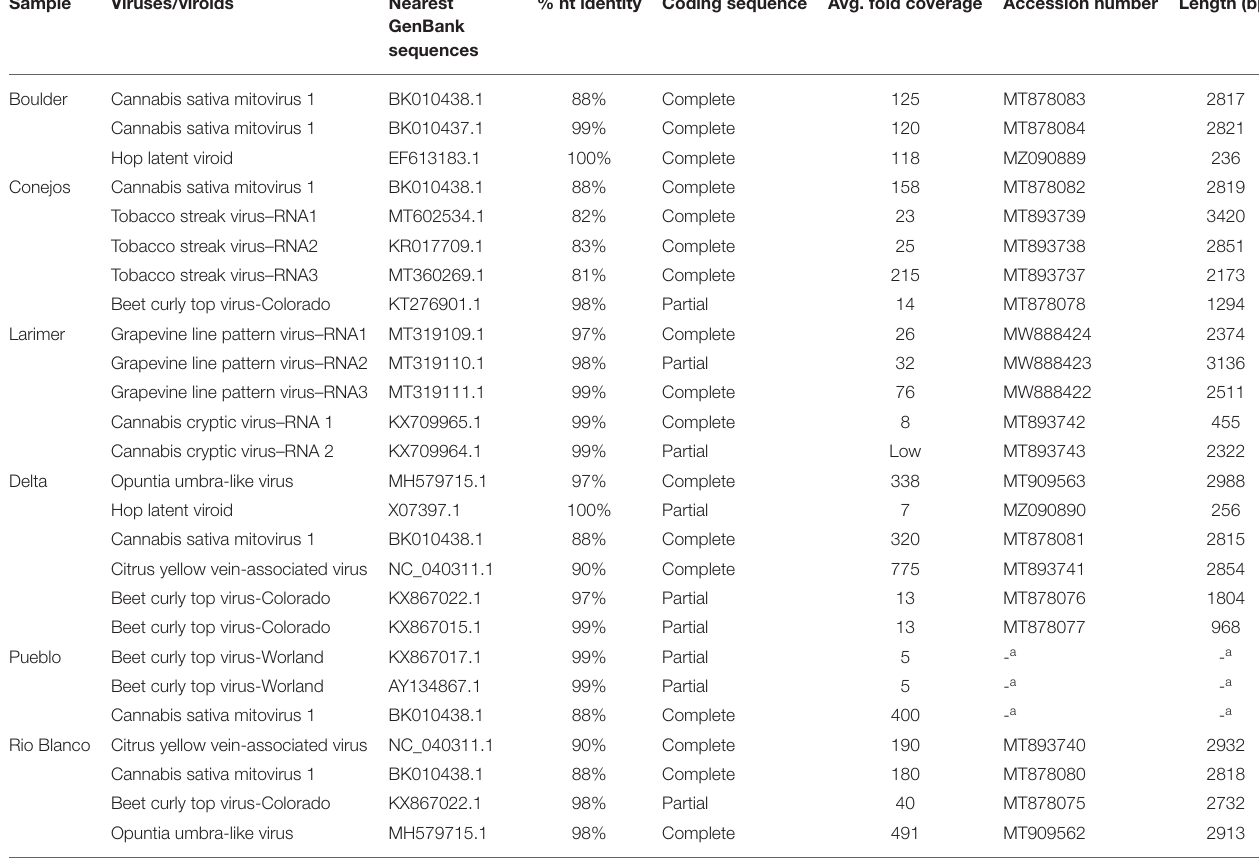
TABLE 3 | Summary of hemp viromes from Colorado by Next Generation Sequencing.